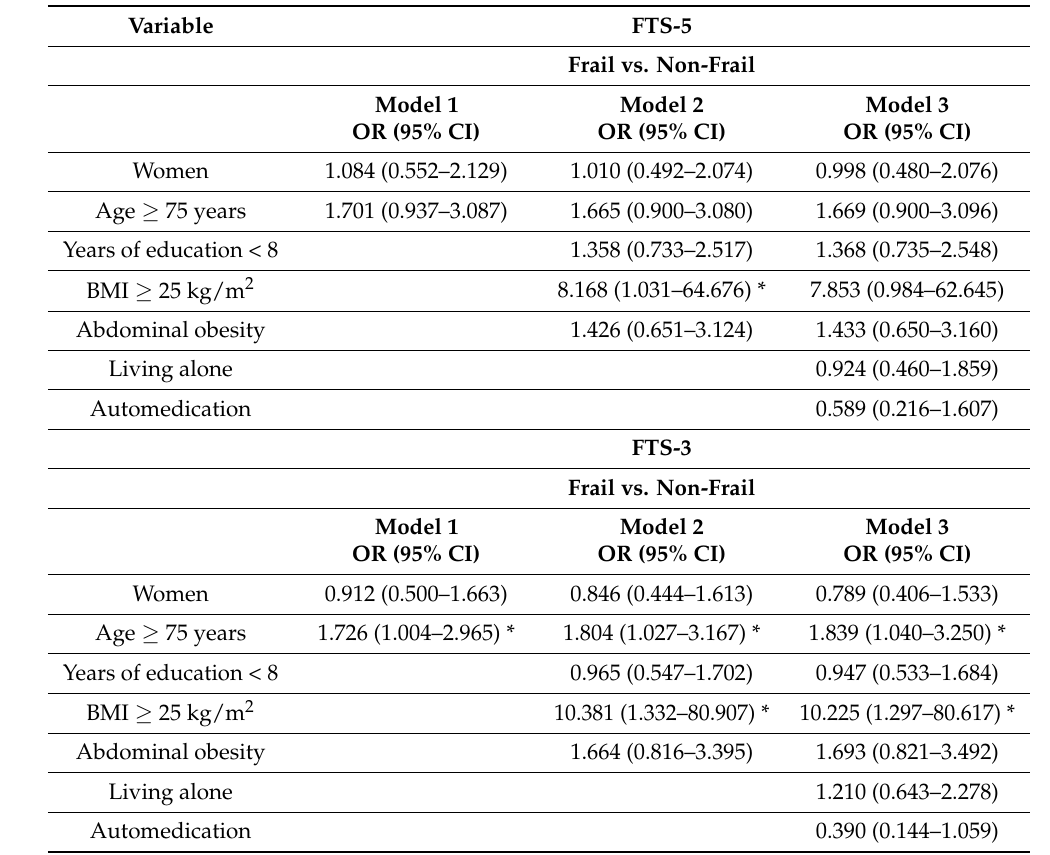
Table 5. Logistic regression for the association of frailty according to FTS-5 or FTS-3 as a dependent variable with variables of relevance in health, adjusted by age and